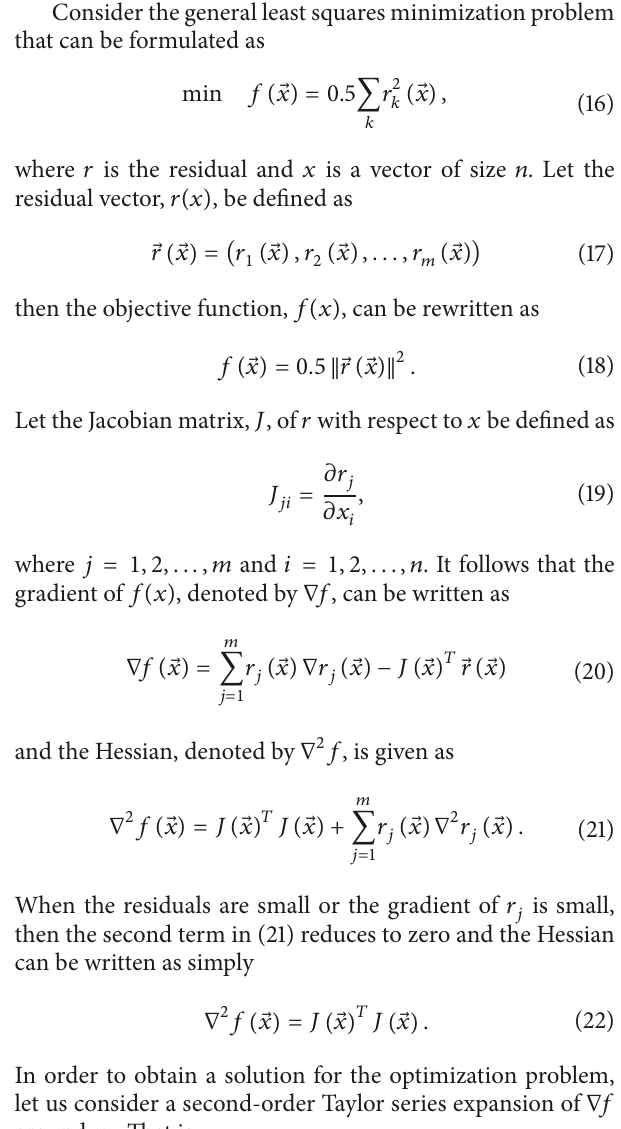
Algorithm 2 (estimating the process parameters of the moni- toring AGC system using the recursive least square